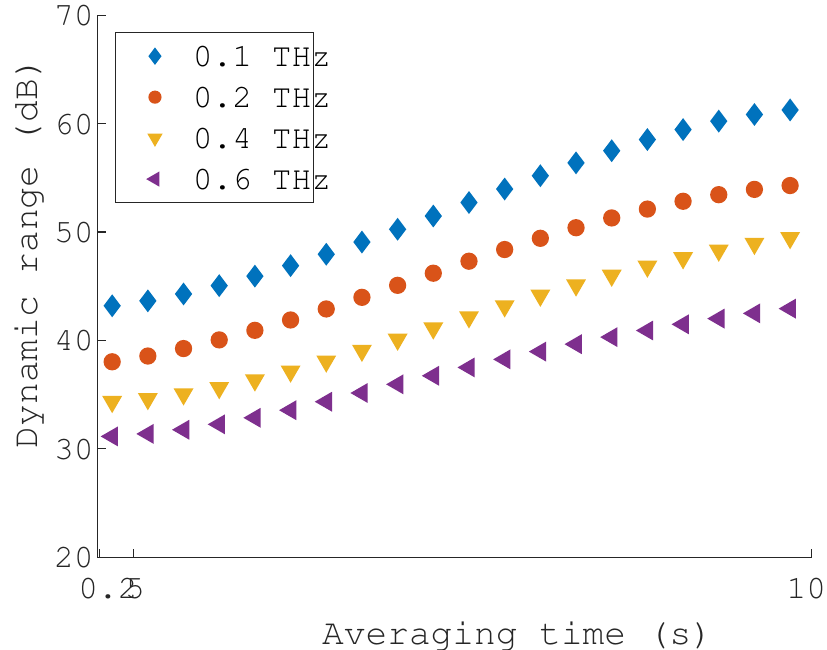
Figure 12. Dynamic range measurement as a function of time and